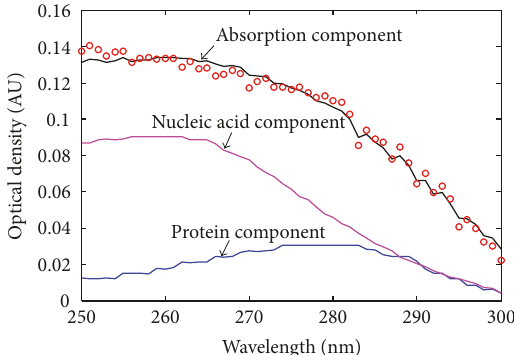
Figure 6: Quantitative analysis of E. coli absorption component: nucleic acid and protein components.